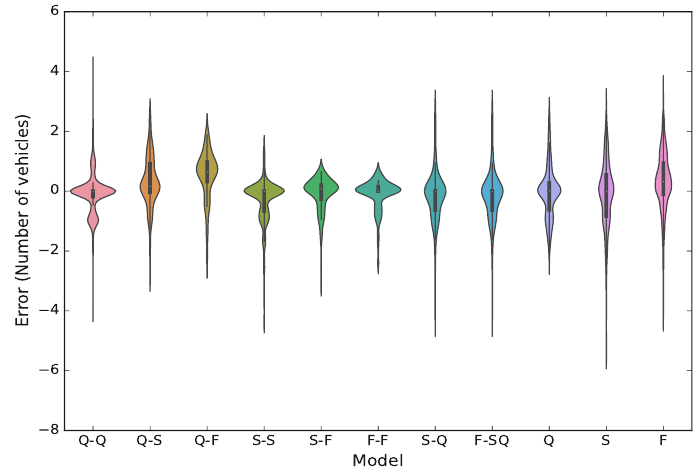
Figure 9. Estimation error distribution obtained for real